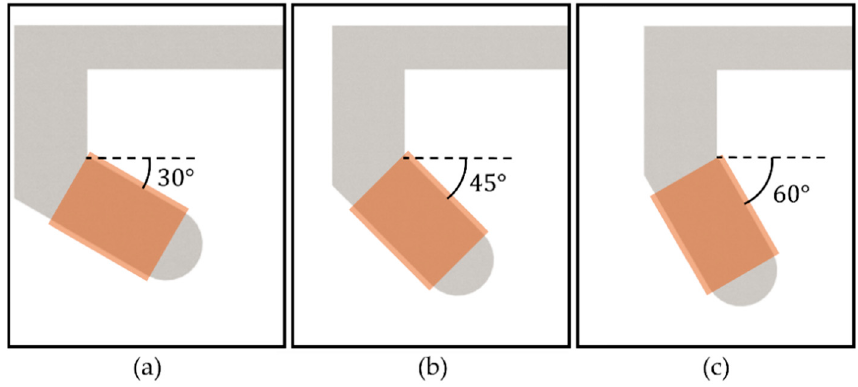
◦ . ( b ) 45 ◦ . ( c ) 60 ◦ . Figure 5. Various tilted angles of the core for the C-Mag. ( a ) 30°. ( b ) 45°. ( c ) 60°.